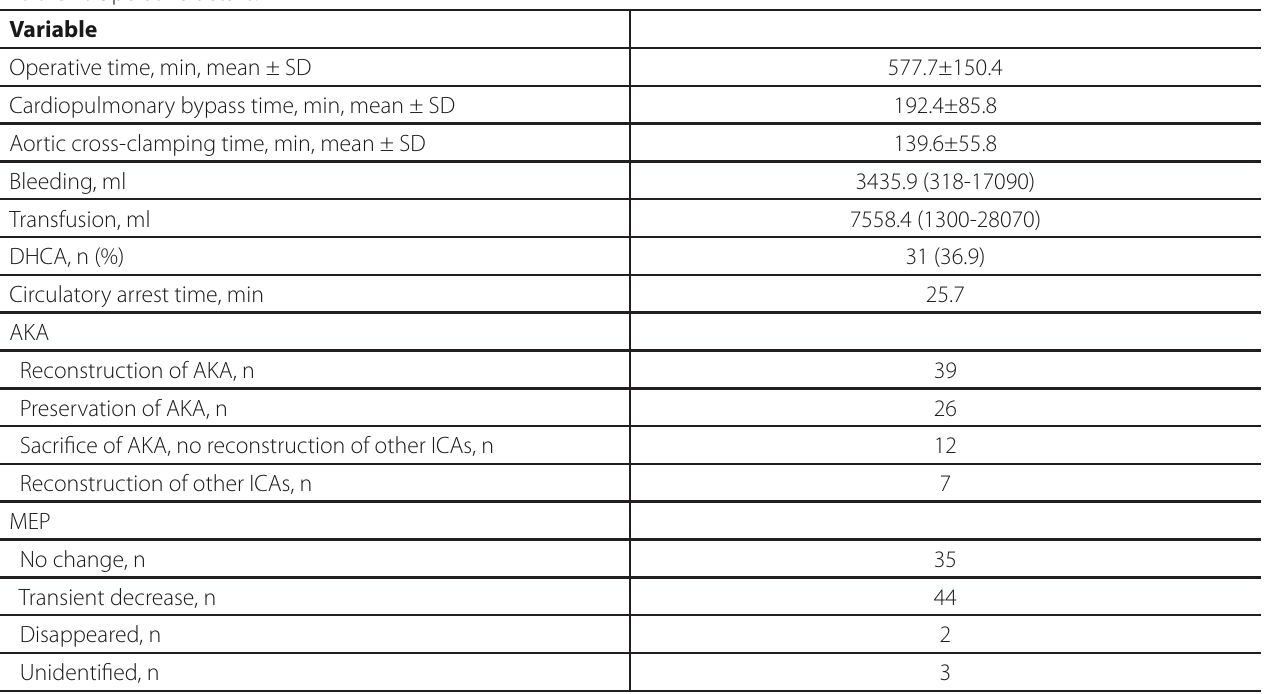
Table 2. Operative